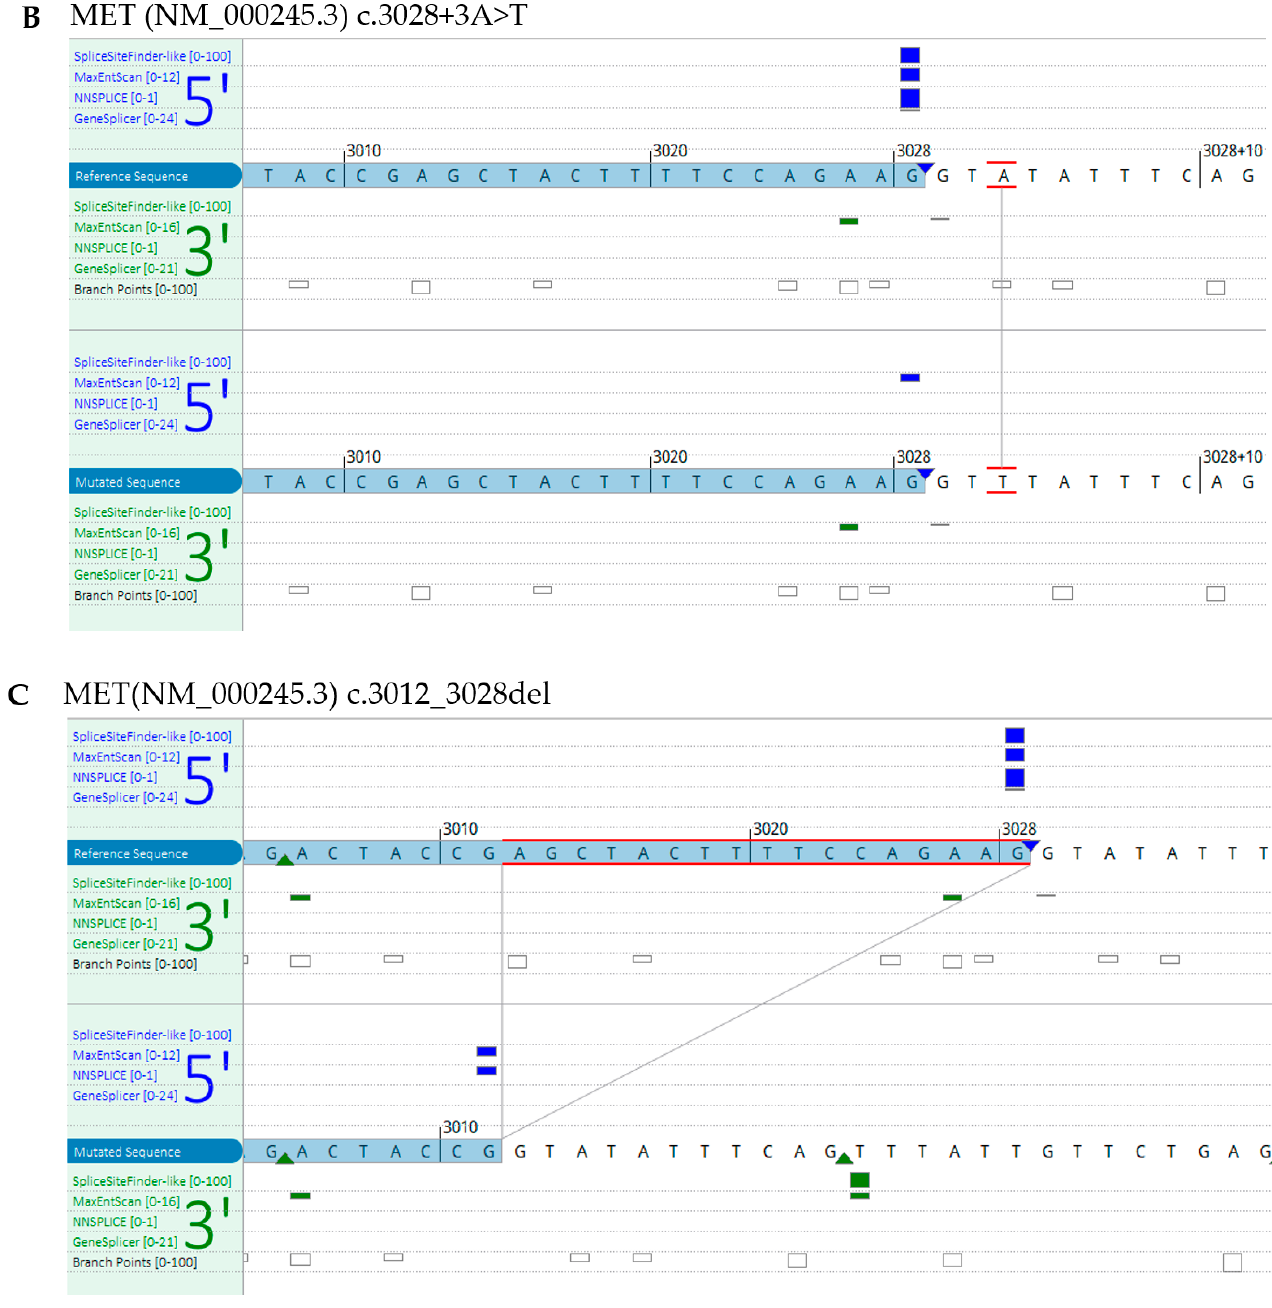
Figure 1. ( A ) Graphic representation of MET exon 13, 14, and 15 sizes, primers for RT-PCR binding sites, and predicted size of wild-type and MET exon 14 PCR products. ( B , C ) Alamut visual prediction of MET splicing with c.3028+3A>T and c.3012_3028del variants. With the use of four splicing predictors, donor prediction signals, shown with vertical blue bars (each bar corresponded to an individual splicing predictor) at the 5 ′ donor sites are reduced, suggesting that these variants alter splicing. Vertical green bars are for 3 ′ acceptor sites showing minimum or no change. Heights of the bars are proportional to splicing strength. Known constitutive signals are displayed as a small blue triangle for 5 ′ or a green triangle for 3 ′ .